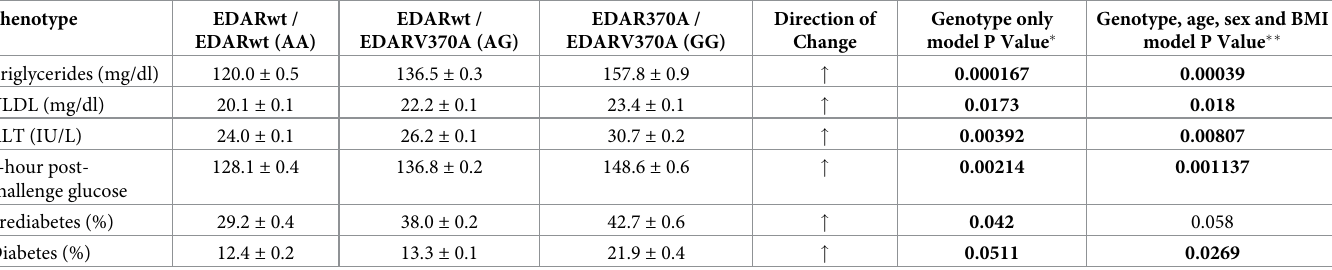
Table 2. Genotype class specific mean values for the phenotypes that were significantly associated with EDARV370A.